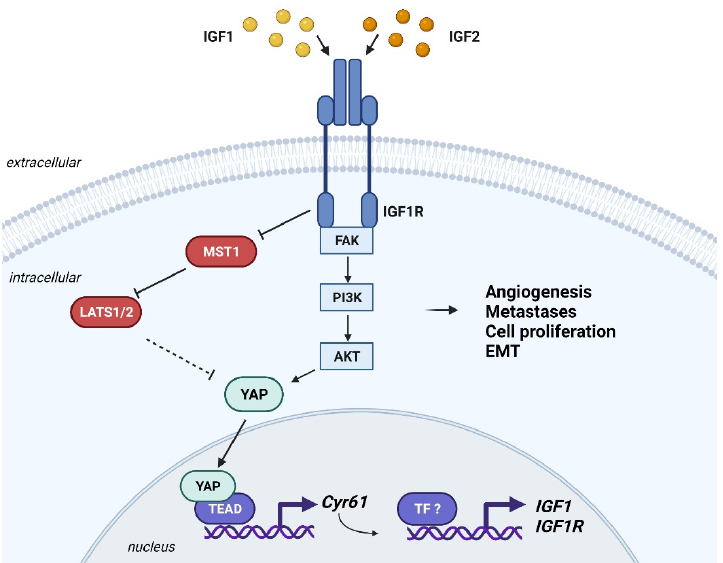
Figure 2. Schematic representation of the functional interaction between the IGF system and the Hippo pathway in cancer. IGF1R might contribute to regulating the Hippo pathway favoring YAP expression and translocation into the nucleus. The IGF1/IGF1R/FAK/Akt/YAP signaling cascade, which promotes YAP nuclear accumulation and expression of its canonical targets, including Cyr61 , is depicted. Conversely, the IGF1R inhibits MST1 expression and the downstream kinase LATS1/2 thereby blocking LATS1/2-driven YAP phosphorylation and degradation. Cyr61 drives mRNA expression of IGF1 and IGF1R but the mechanisms are still poorly defined. Biological responses evoked by the IGF/Hippo pathway in cancer are reported.